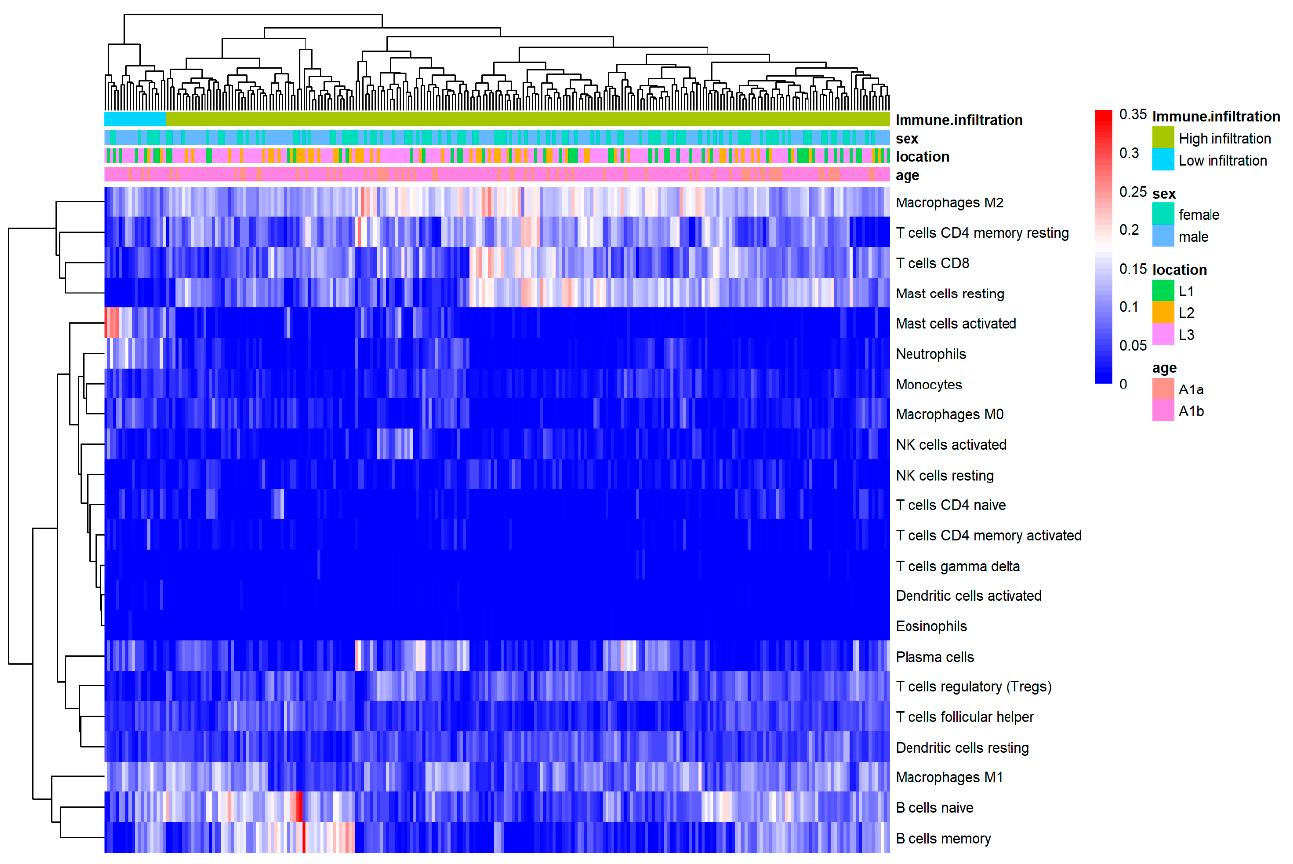
Figure 2. Heatmap of the normalized absolute abundance for each immune cell type in individual samples. Location: L1 ileal-only location, L2 colon-only location, L3 ileo-colonic location; Age: A1a < 10 years old, A1b ≥ 10 years old.